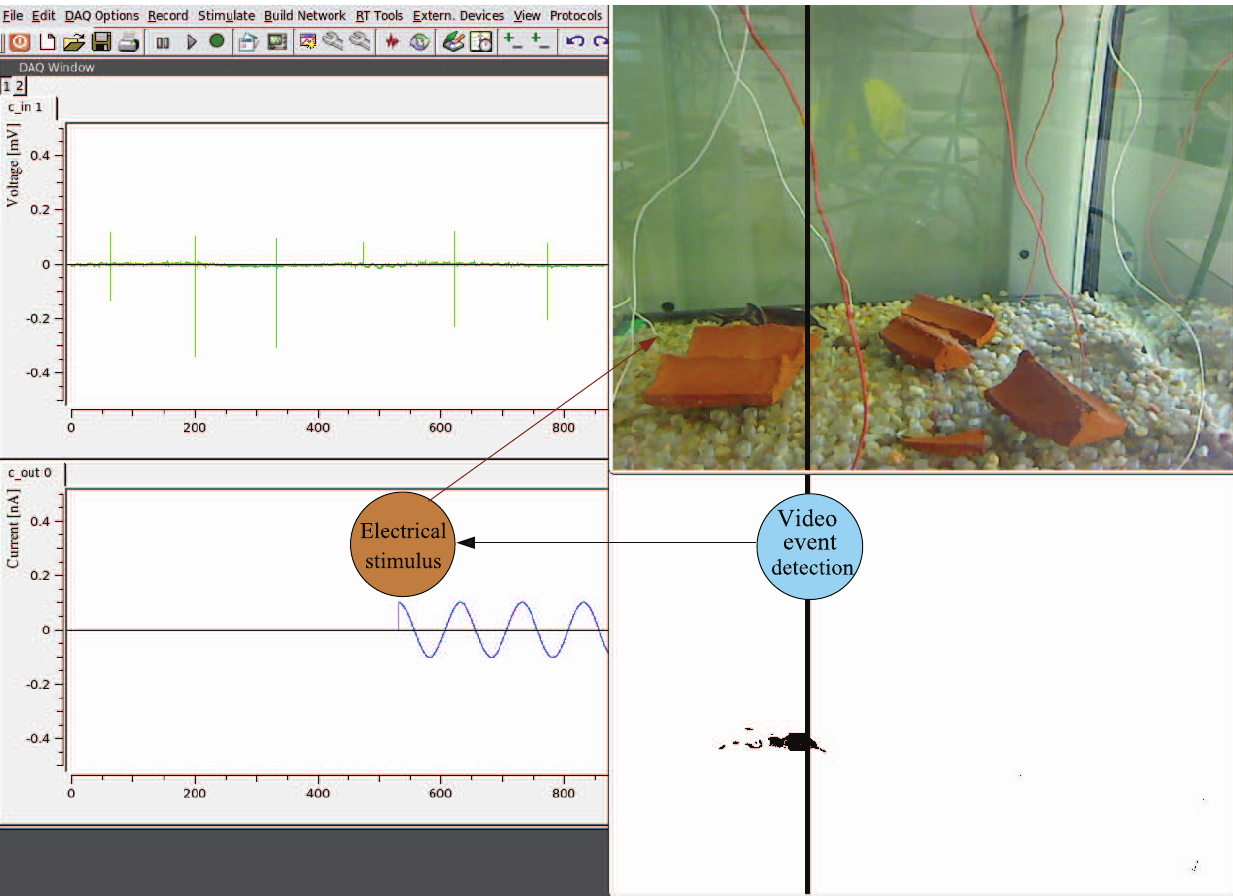
Figure 6. Virtual water fence through position-dependent stimulation. When the fish crosses a virtual barrier (vertical black line on the right panels) an aversive stimulus is delivered (bottom left) so that the fish stays in a specific space of the water tank. The top left panel shows the electrical activity of the fish.